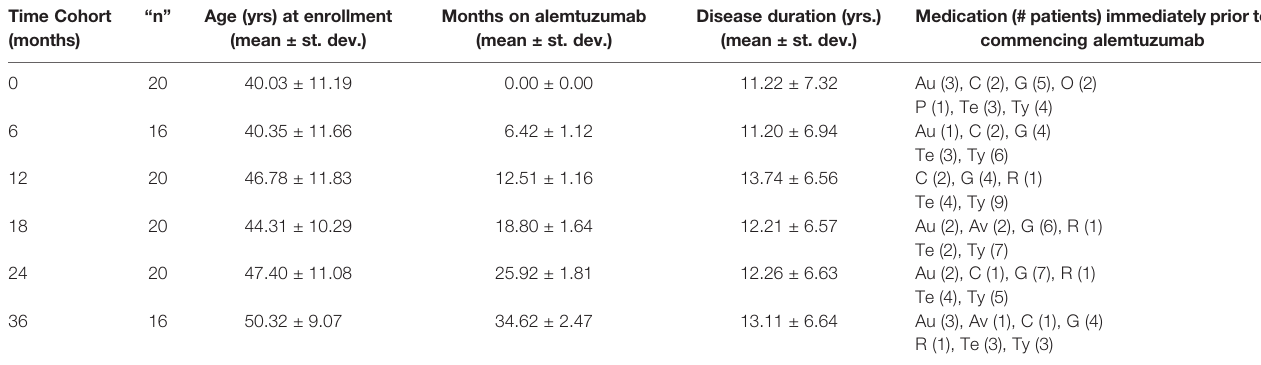
TABLE 1 | Basic characteristics of the different patient cohorts. Time Cohort